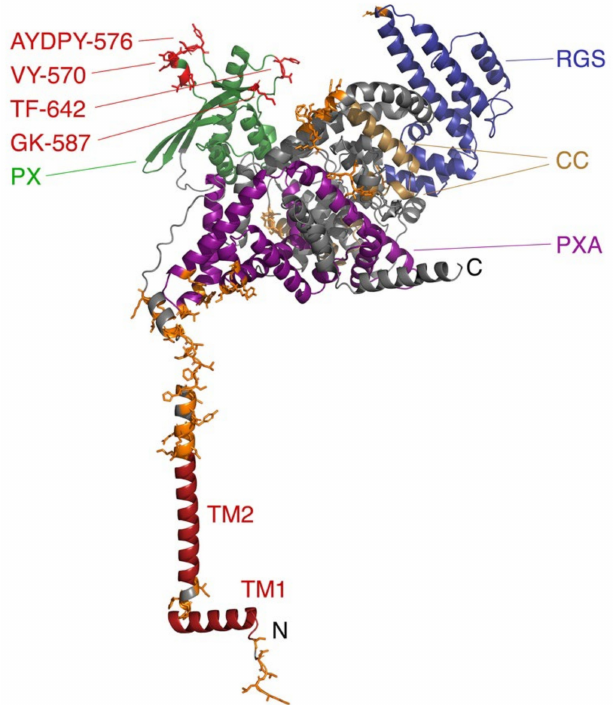
Figure 7. Structure of full length Snx13 showing its membrane interactive elements. The two TM helices, coiled coils, PXA, RGS, and PX domains of the AlphaFold2 model are colored dark red, sand, magenta, blue, and green, respectively. The rest of the backbone ribbon is gray. The sidechains of residues with membrane binding propensity scores of at least 30 in the PX domain and other peripheral elements are colored red and orange, respectively, while only those in the PX domain are labelled. The N- and C-termini are indicated. This model contains uncertain aspects including the perpendicular positioning of two TM helices, the inclusion of the two predicted coiled coils in a larger all-helical domain, and the orientation of the multitude of peripheral membrane docking elements including those of the PX domain away from each other and the TM